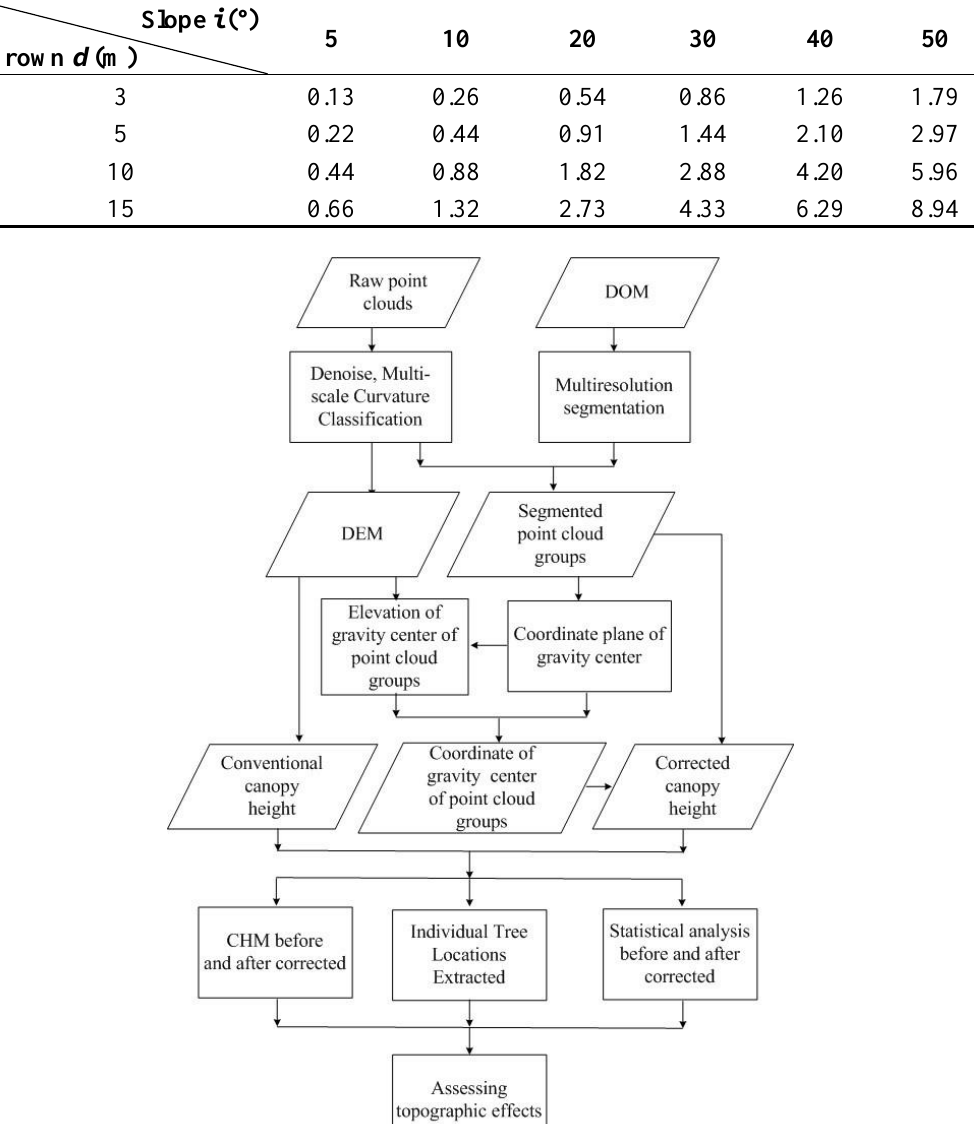
Table 2. Maximum canopy height difference calculated by slope gradient and crown.